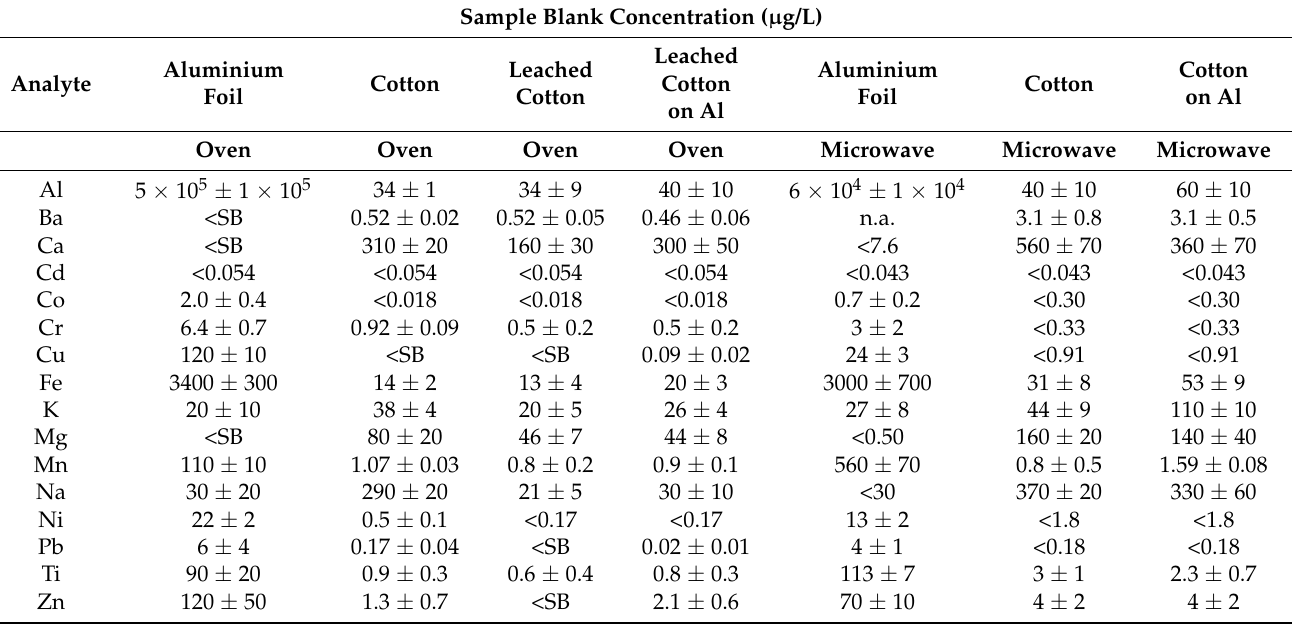
Table 2. Results of preliminary checks—sample blank concentrations.